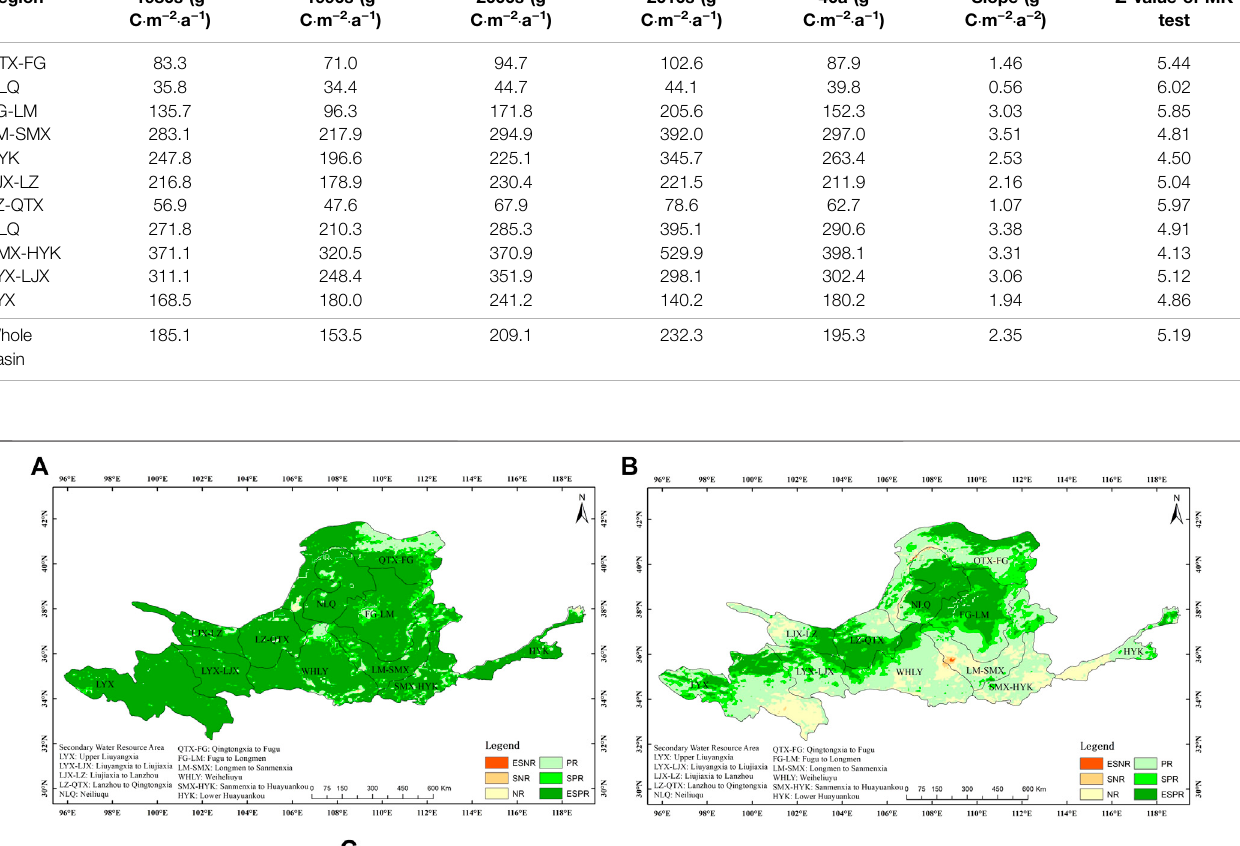
TABLE 2 | Statistical values of NPP in secondary water resource areas. Region